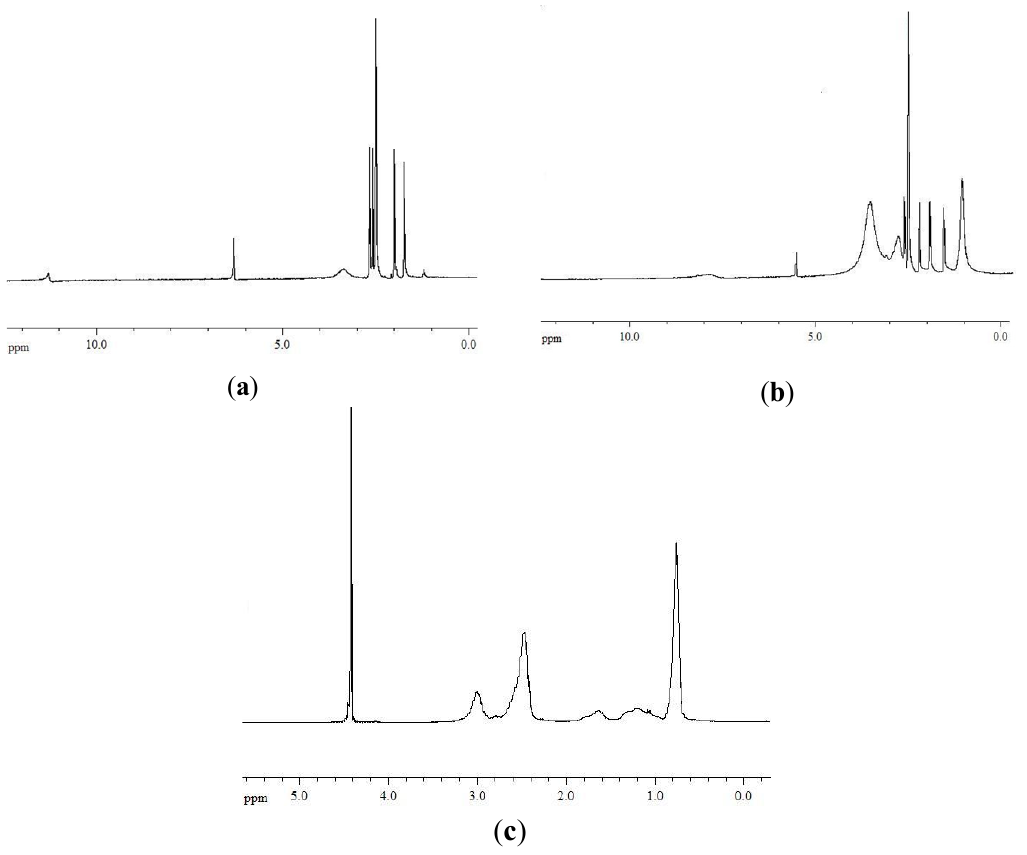
Figure 4. 1 H-NMR spectra of usnic acid ( a ), pAcDED pAcDED ( c ). T=0